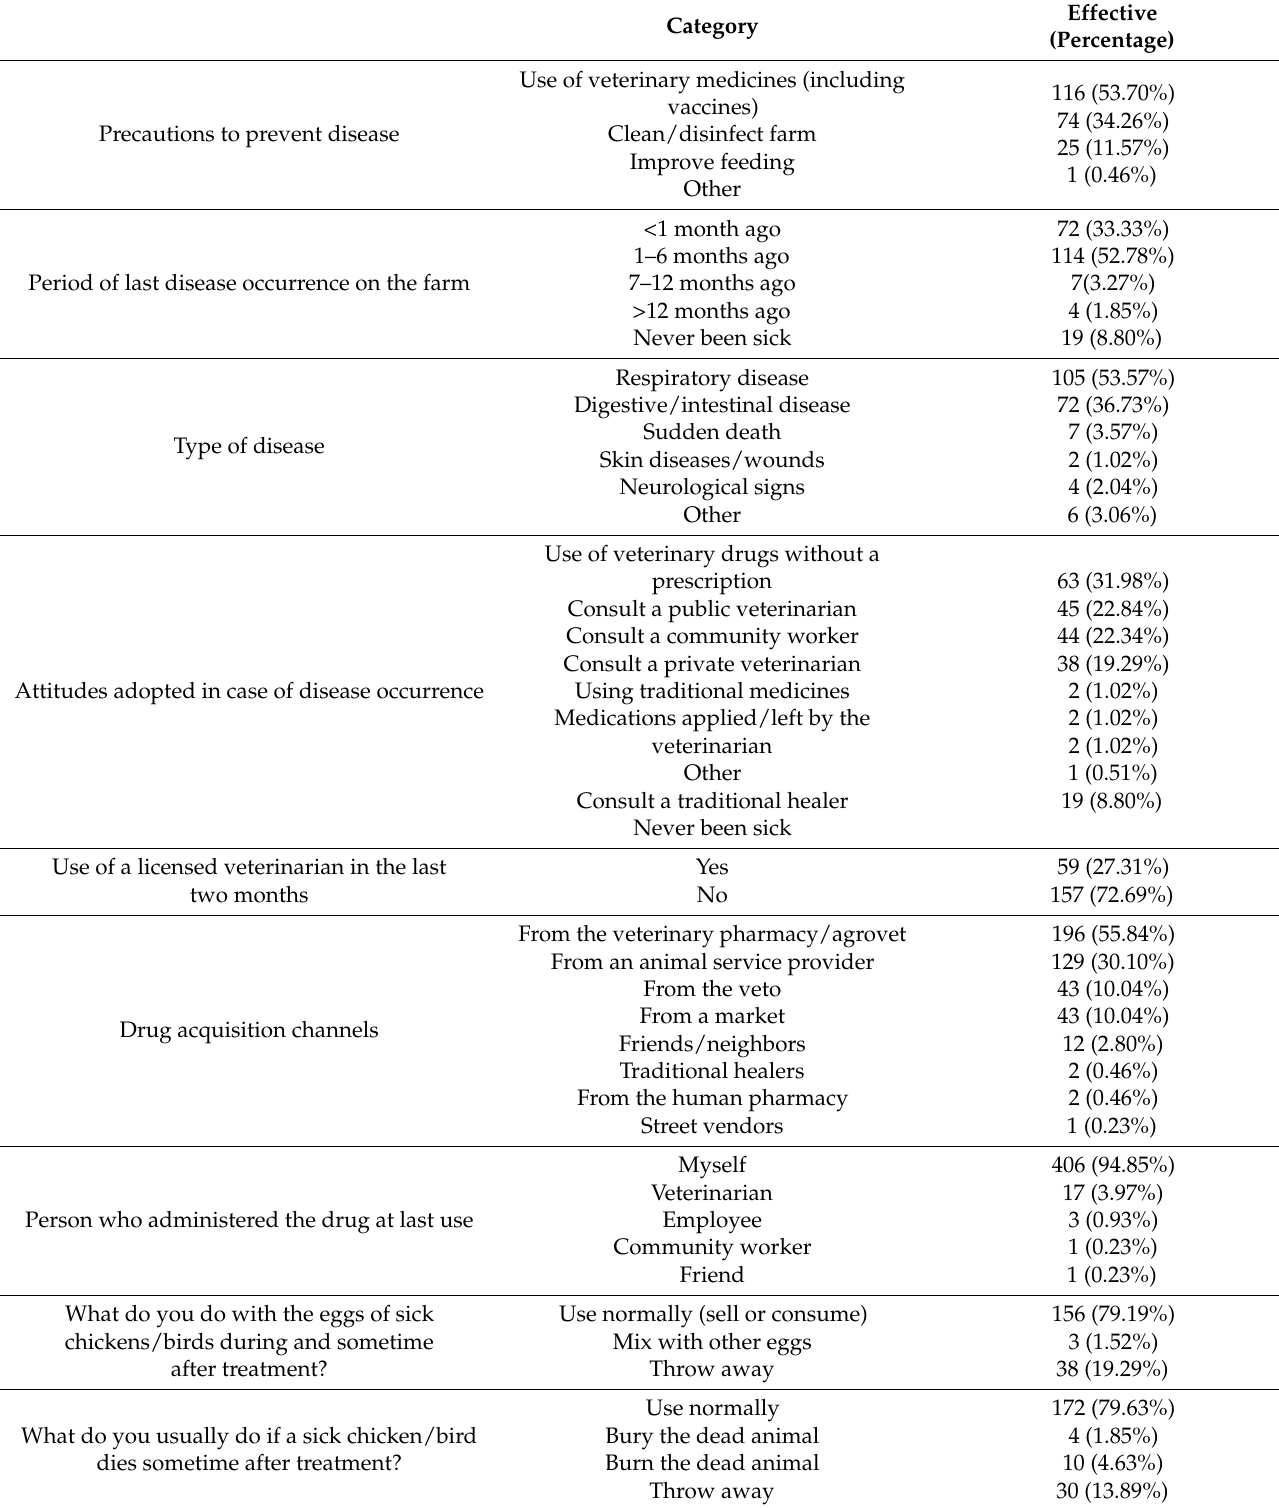
Table 3. Biosecurity practices and attitudes encountered on the